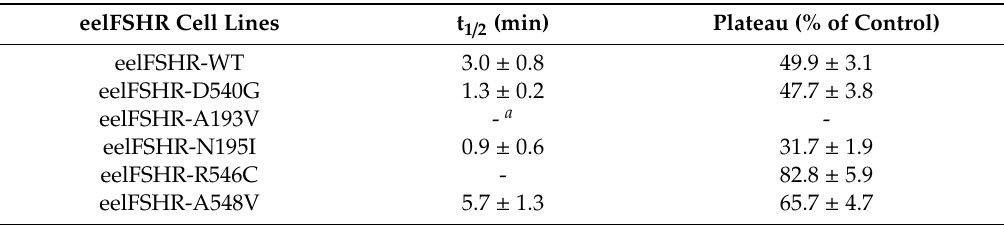
Table 3. Rates of cell surface loss of receptors in transient transfected cell lines expressing the wild-type eelFSHR and mutants thereof.